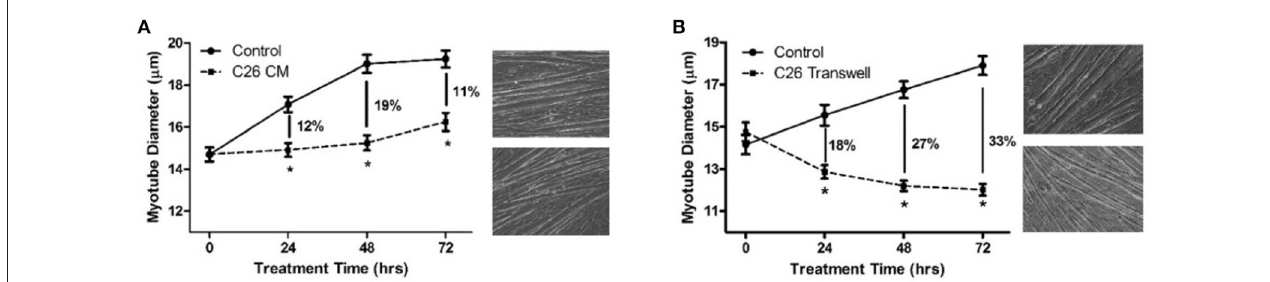
FIGURE 2 | Myotube diameters in response to treatment with C26 CM or C26-Transwell inserts. (A) Treated with DM (control) or C26 CM for 72 h. DM or C26 CM was refreshed every 24 h and photographs of the wells were taken just before feeding. Percent atrophy indicated for each treatment time point in graph. (B) Treated with DM or Transwell inserts containing C26 tumor cells, medium refreshed every 24 h, again, photographs of the bottom wells taken just before feeding. On the right of each graph are photographs of phase images of representative wells of control (top) and treated (bottom) myotubes at 72 h. * P < 0.05 compared to control value.